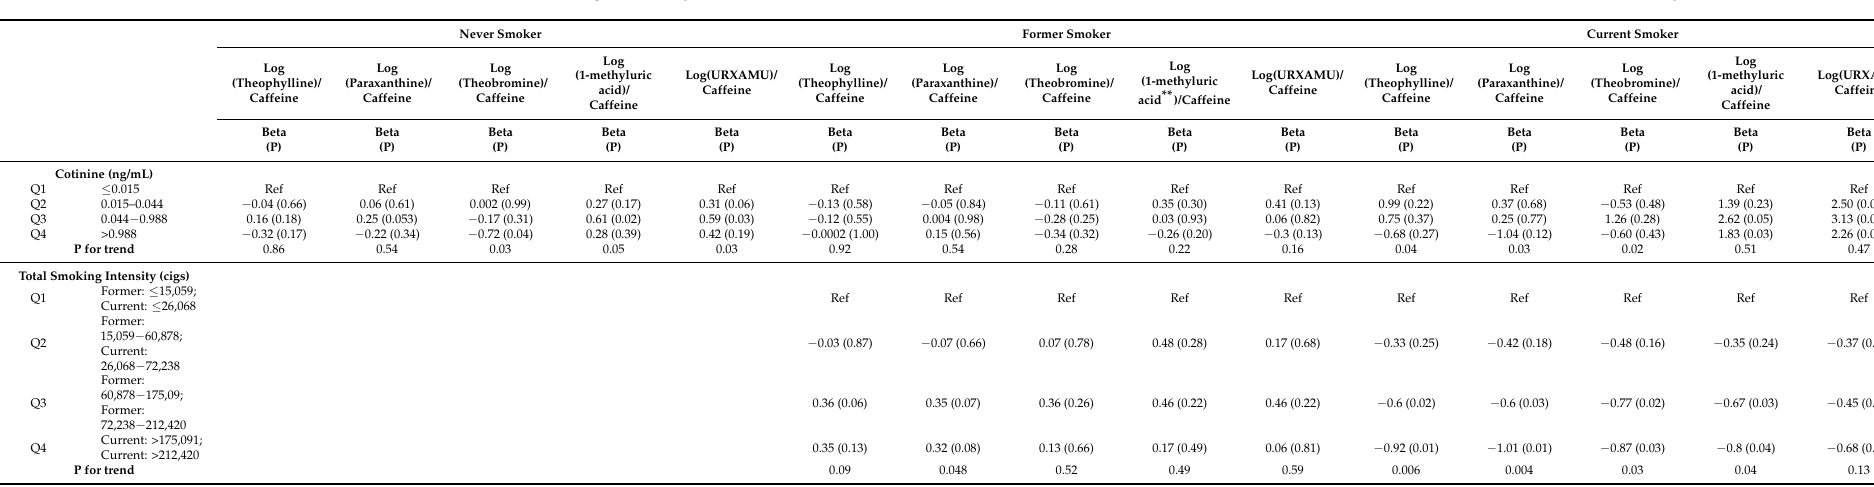
Table 3. Secondhand smoke and smoking intensity in relation to caffeine metabolite indices (caffeine intakes was calculated from the 24-h recall on day 1). NeverSmoker FormerSmoker